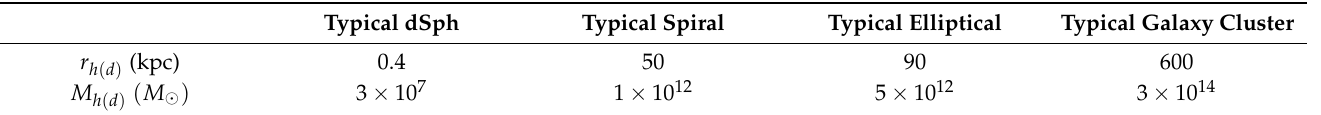
Table 2. Typical halo radius and mass for dsPh, spirals, elliptical galaxies, and galaxy clusters, adopted in [32] for testing of the RAR model. Typical dSph Typical Spiral Typical Elliptical Typical Galaxy